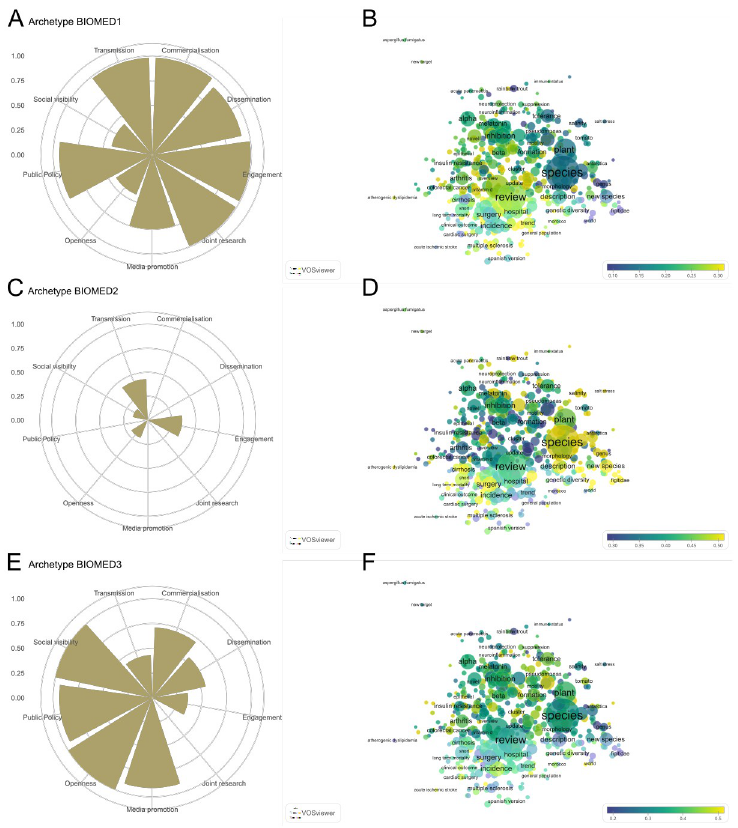
Fig 6. Parameters and topic maps for three archetypes in BIOMED field. Archetypes that emerge for all biomedical cases (A, C and E), along with overlay maps of α scores corresponding to words included in the titles of research publications (B, D and F). Words follow a colour grading based on their maximum or minimum value, the extreme values being yellow (for those present in publication titles of cases resembling a given archetype) and blue (those which are not present in the publication titles of cases resembling the archetype). An online version of this map is available at: http://sl.ugr.es/biomedarchetypes.